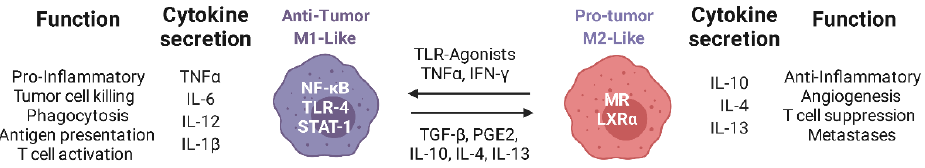
Figure 1. Schematic representation of the functions of M1-like and M2-like macrophages: Immunosuppressive molecules in the TME contribute to the polarization of TAMs towards an M2-like phenotype, with consequent support of tumor growth. Re-polarization of TAMs with TLR ligands and nanotherapeutics can promote their switch to an M1-like pheno- type leading to the infiltration of activated cytotoxic T cells in the TME, ensuring the control of tumor growth. Created with